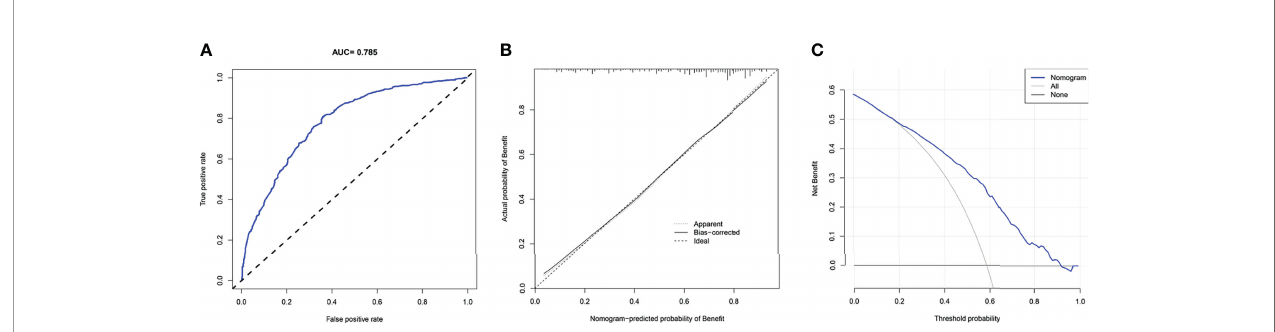
FIGURE 4 | The receiver operating characteristic curve (A) , calibration curve (B) , and decision curve analysis (C) of the screening nomogram in the training set.